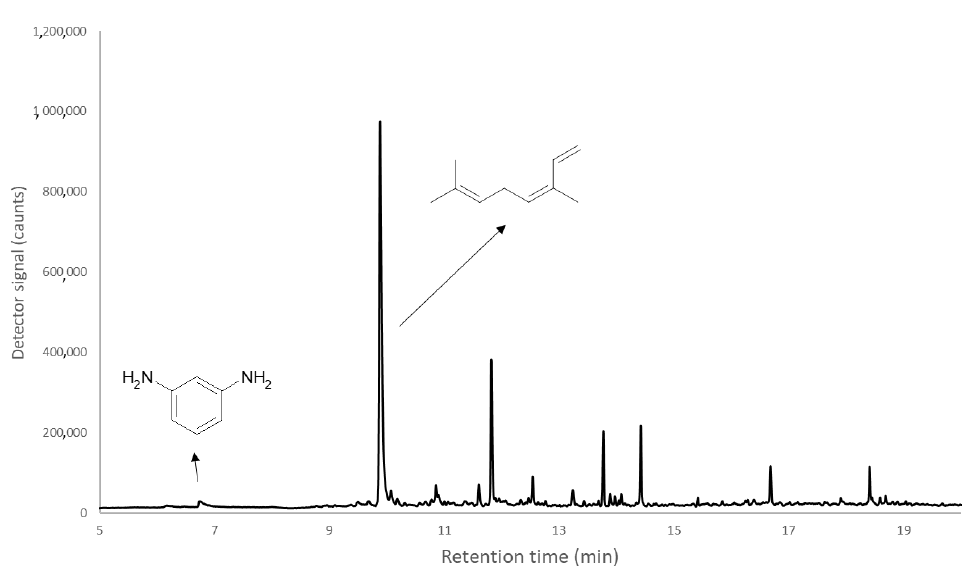
Figure 2. Chromatograms of the VOCs isolated from sample from infected with P. larvae colony. The unlabelled peaks are typical degradation products of silane from polydimethylsiloxane fibre used in solid phase